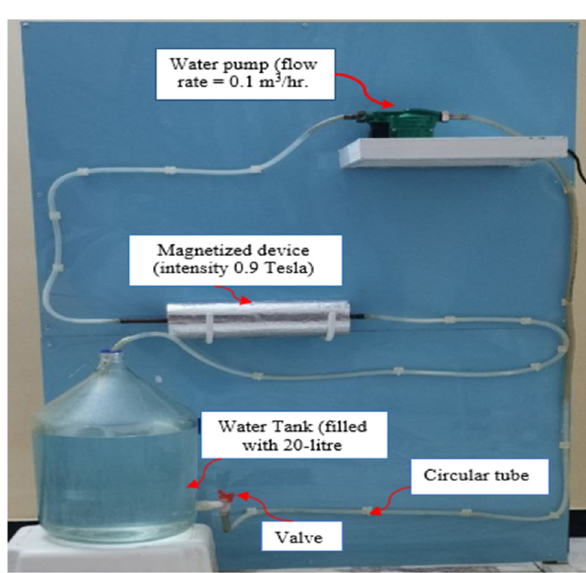
Figure 2: Magnetized water cycle developed in this